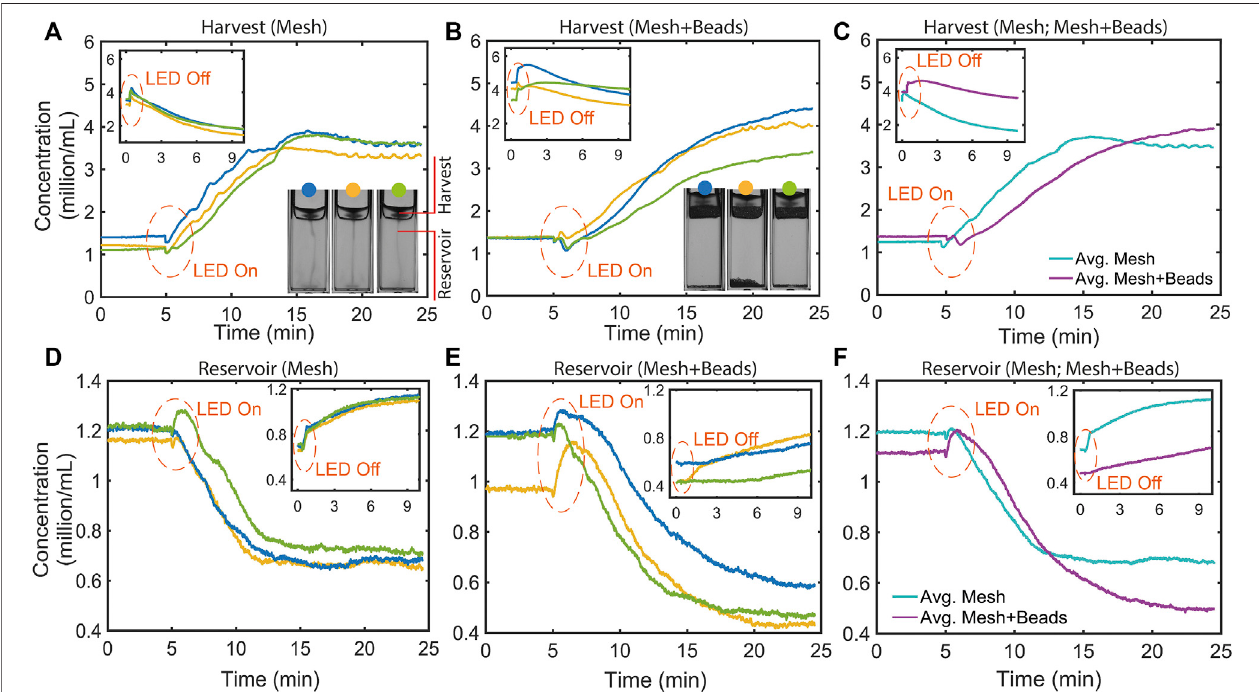
FIGURE6 | Temporal concentration pro fi les in theupper harvest region above a mesh or mesh + beads, after the LED is switched on and off (insets),as indicated. (A) Threerepeatsformicroalgaephototacticallyconcentratingabovethebaremesh.Inset:concentrationriseanddecayaftertheLEDisswitchedoff. (B) Asin (A) ,butfor themesh+beads(400 mg)case. (C) Timepointaverageoftheconcentrationpro fi lesshownin (A,B) .Theconcentrationforthemesh-onlycasesaturates ∼ 10 minafter the LED is switched on, whereas it keeps on increasing towards a higher saturation concentration in the mesh + beads case. When the LED is switched off, the concentration initially increases and then decays, for the reasons discussed in the text. (D) Three repeats for pro fi les in the lower region for the mesh only case. Inset: concentration rise after the LED is switched off. (E) As in (D) but for the mesh + beads case. (F) Time point average of the concentration pro fi les shown in (D, E) . For the mesh-onlycasethepro fi ledecaystoaconstantvaluesoonerthanmesh+beads.Theinsetshowshowtheconcentrationsforbothcasesriseinthelowerregionafterthe LED is switched off, with a greater rise for the more leaky mesh-only case.